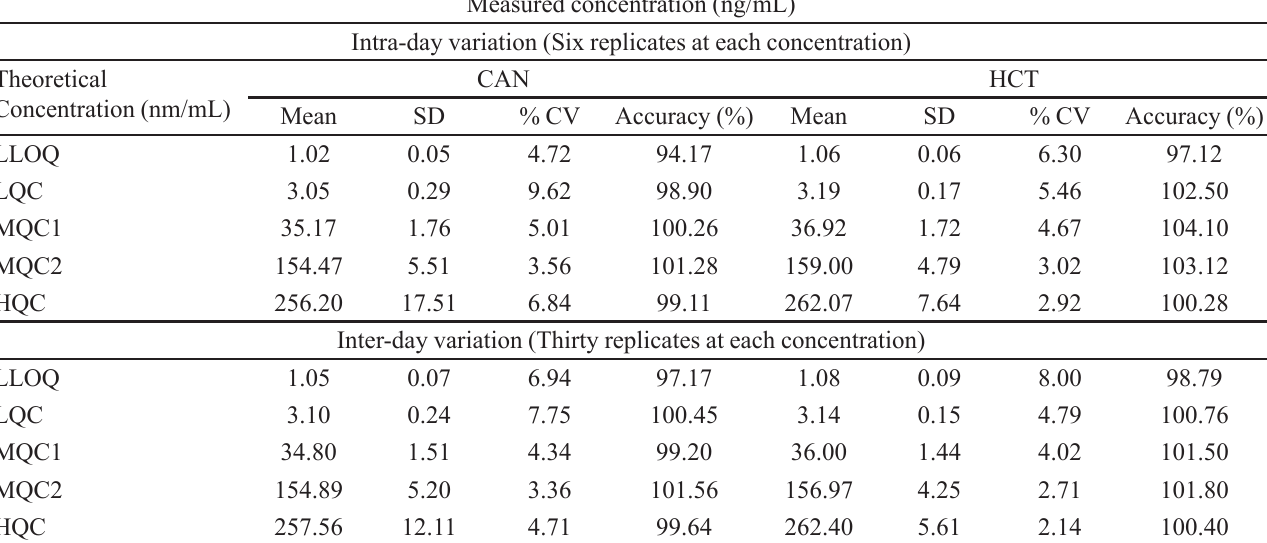
TABLE IV - Intra and inter-day precision of CAN and HCT QC samples Measured concentration